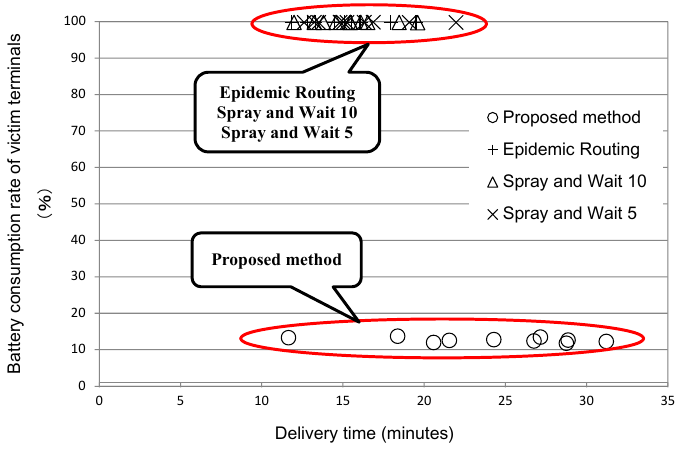
Figure 15. Battery consumption rate of victim terminals and delivery